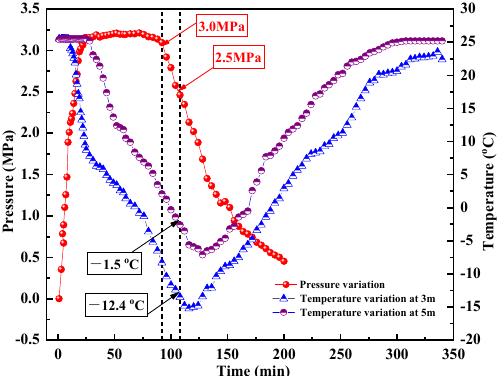
Figure 9. Temperature–pressure variation curves.